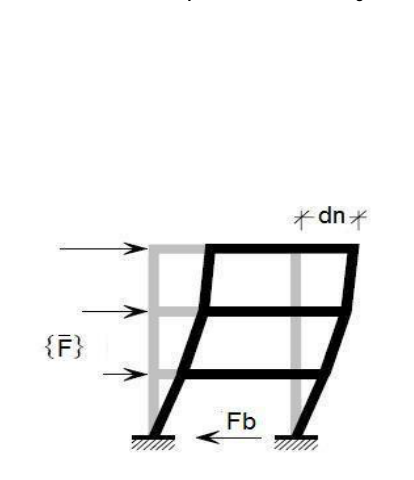
Fig. 8. Pushover Analysis of the MDOF